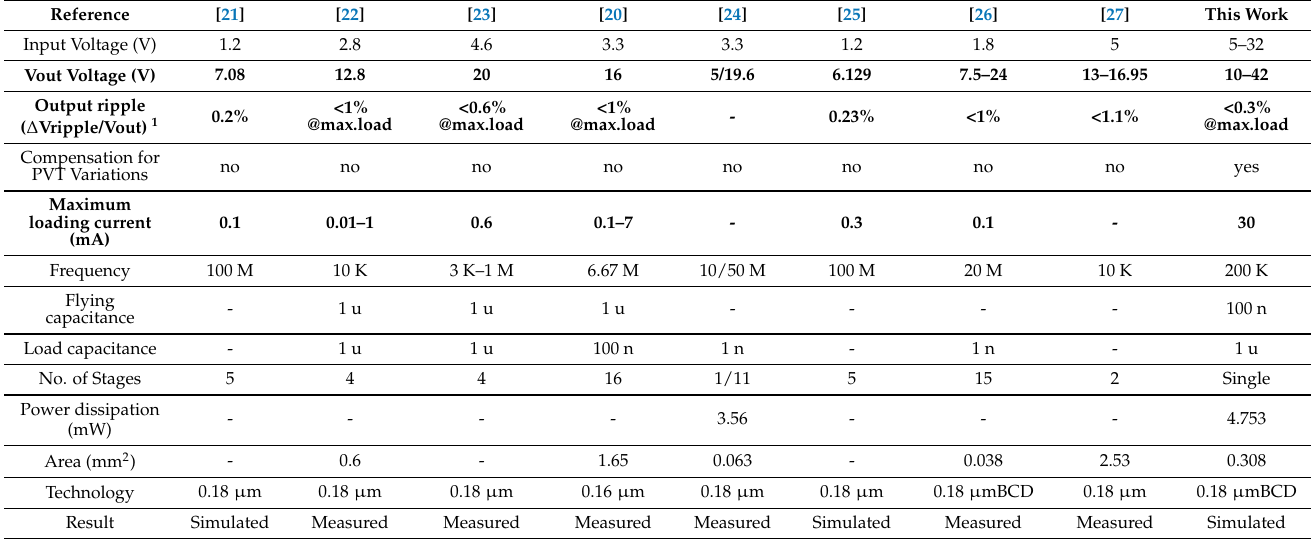
Table 3. The comparison results of the performance of